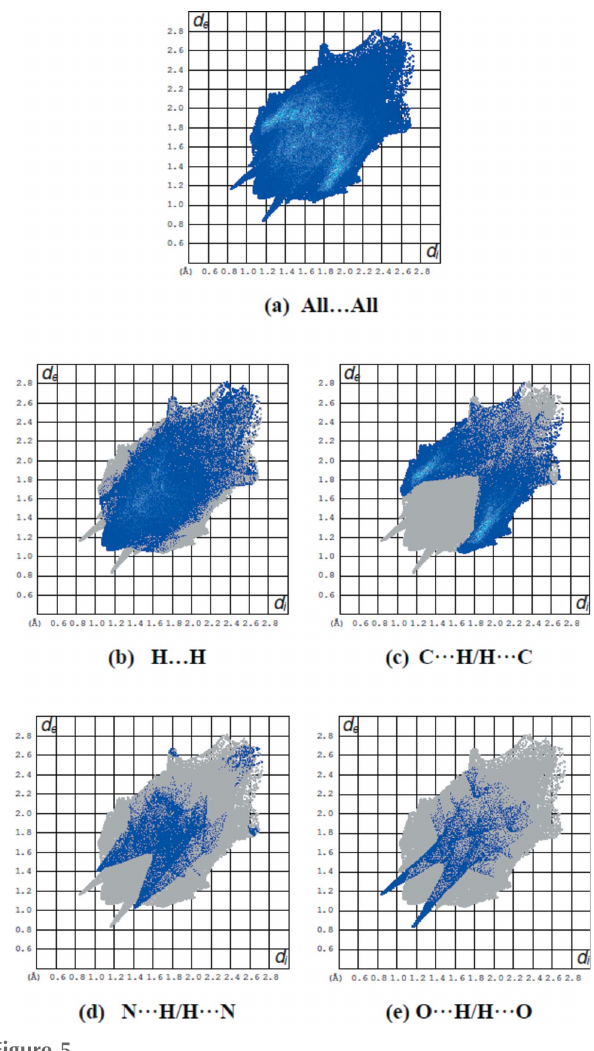
Figure 5 Two-dimensional fingerprint plots of the title compound, showing ( a ) all interactions, and delineated into ( b ) H (cid:3)(cid:3)(cid:3) H, ( c ) N (cid:3)(cid:3)(cid:3) H/H (cid:3)(cid:3)(cid:3) N, ( d ) C (cid:3)(cid:3)(cid:3) H/ H (cid:3)(cid:3)(cid:3) C and ( e ) O (cid:3)(cid:3)(cid:3) H/H (cid:3)(cid:3)(cid:3) O interactions [ d e and d i represent the distances from a point on the Hirshfeld surface to the nearest atoms outside (external) and inside (internal) the surface,